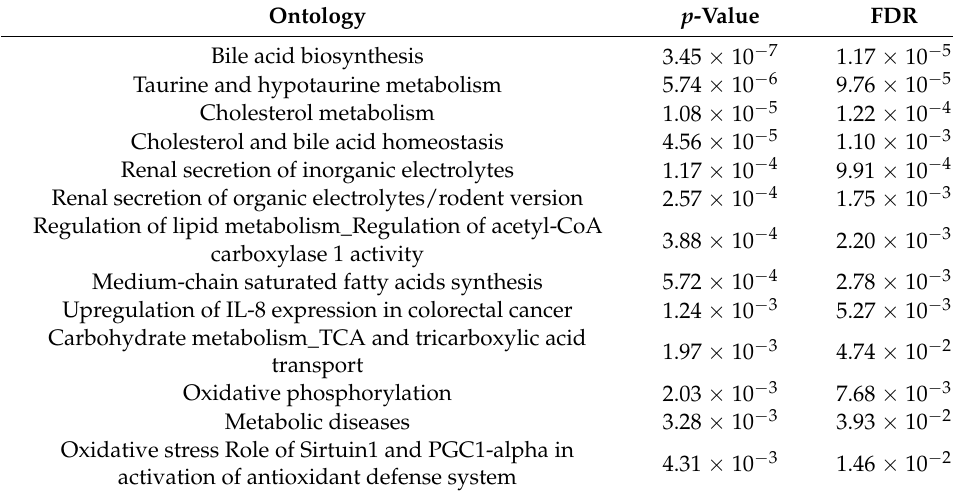
Table 3. Ontologies enriched by Hemangiosarcoma vs. Exposure.